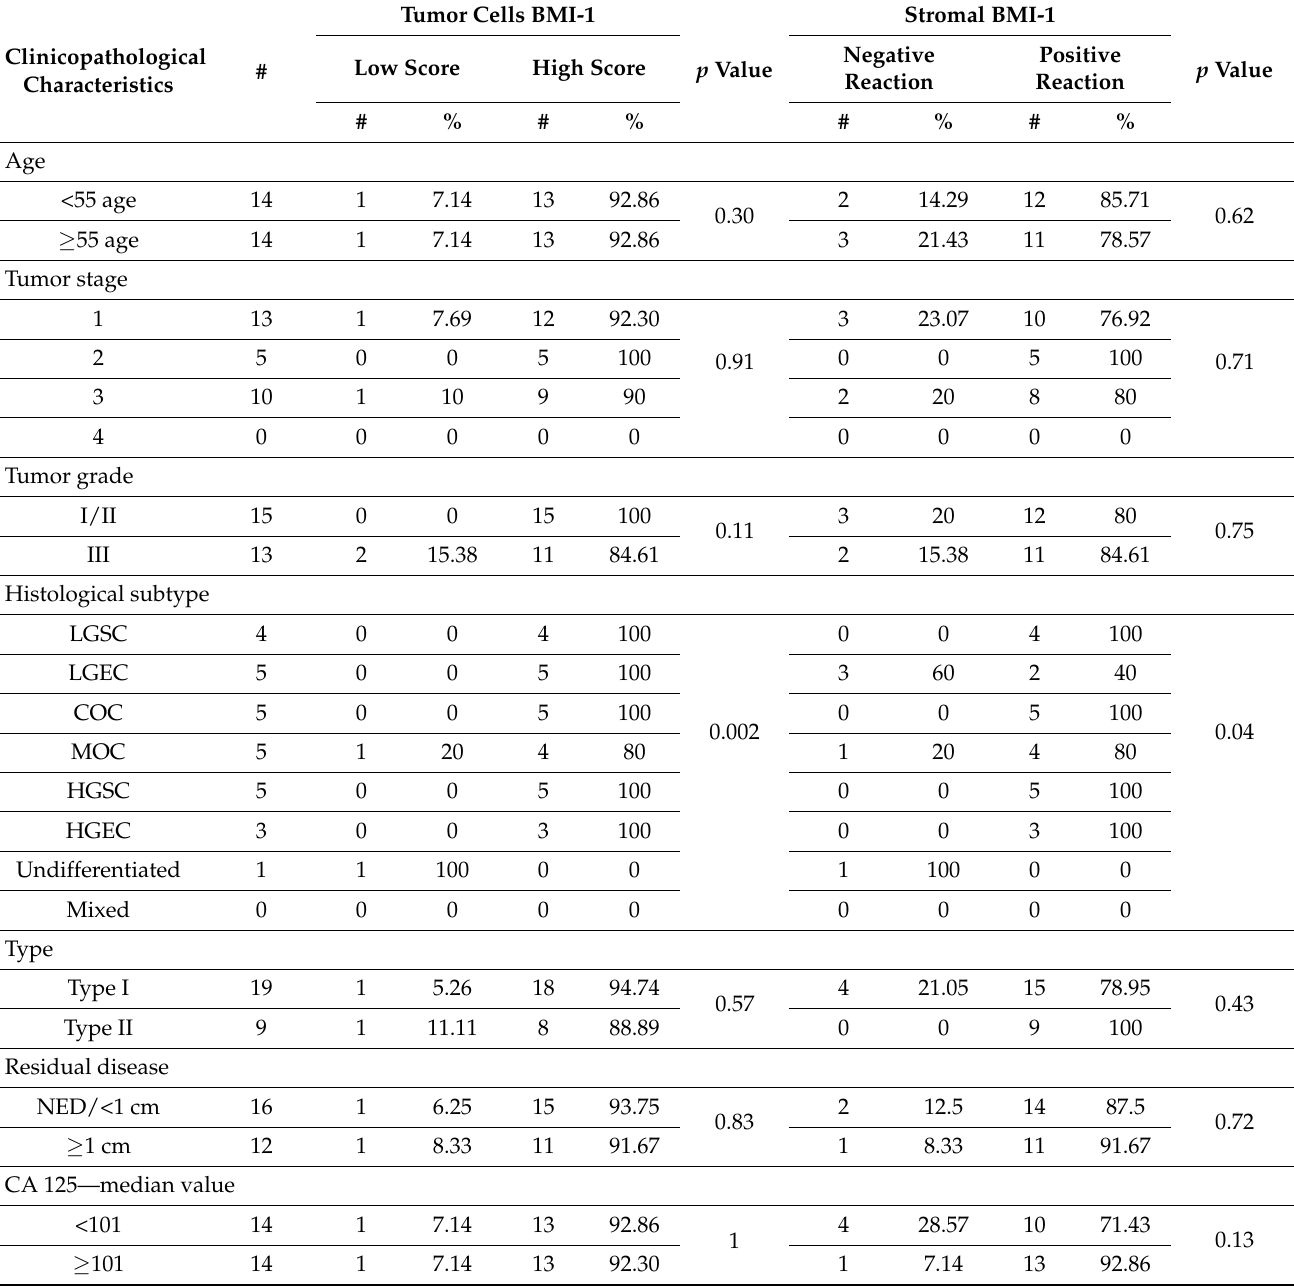
Table 3. Correlations between BMI-1 expression in tumor stroma and clinicopathological parameters—NEOC group.